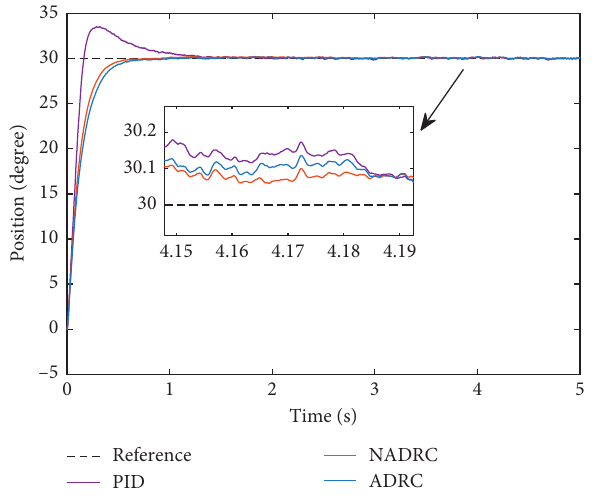
Figure 8: Step response simulation.